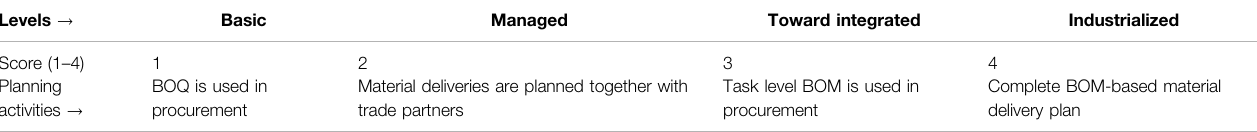
TABLE 5 | Planning